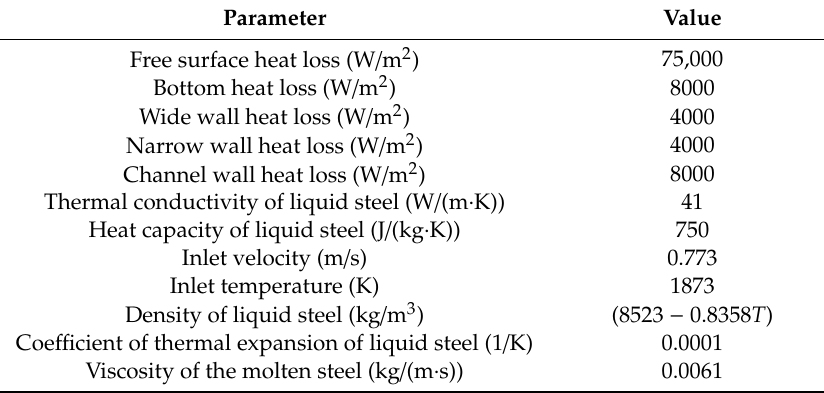
F + Table 3. Initial and boundary condition for tracer transport.